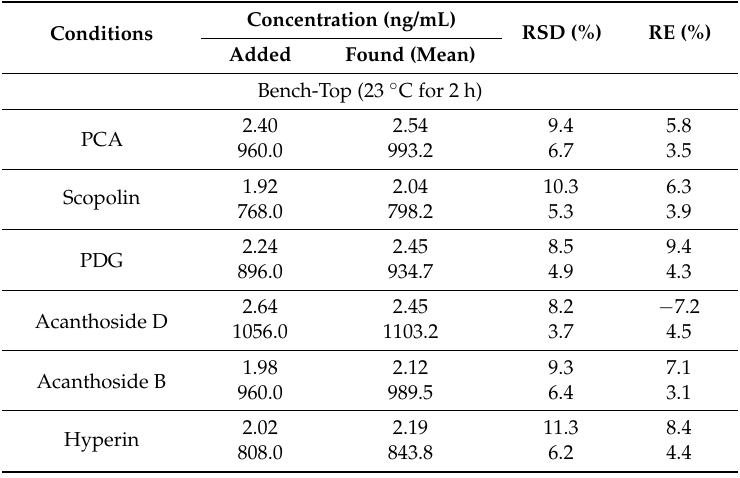
Table 2. Stability data of six components in rat plasma under different conditions.